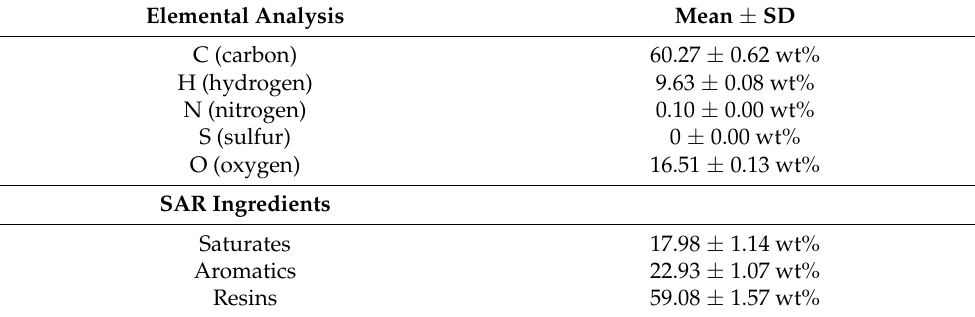
Table 2. Chemical characteristics of discarded chewing gum